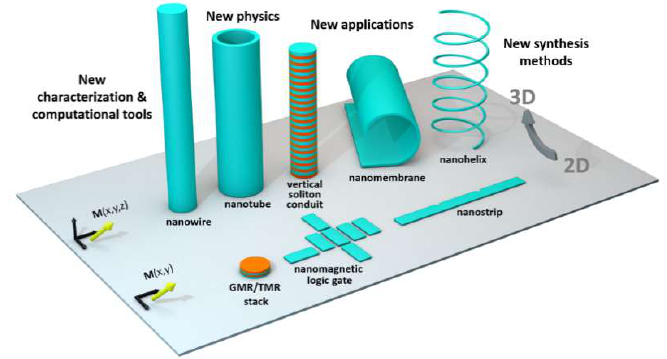
Figure 1. Transitioning from two-dimensional (2D) to three-dimensional (3D) nanomagnetic systems requires new synthesis methods, new characterization techniques, and new computational tools. This transition opens a new set of possible applications, as well as new physical phenomena arising from the interplay between 3D properties and magnetization at the nanoscale. Typical nanostructure scales (e.g., nanowire/nanotube diameters, 2D nanostrip widths, curvature radii of nanohelices and nanomembranes) are 30–500 nm, i.e., a few times a characteristic magnetic length of the system such as the dipolar exchange length.